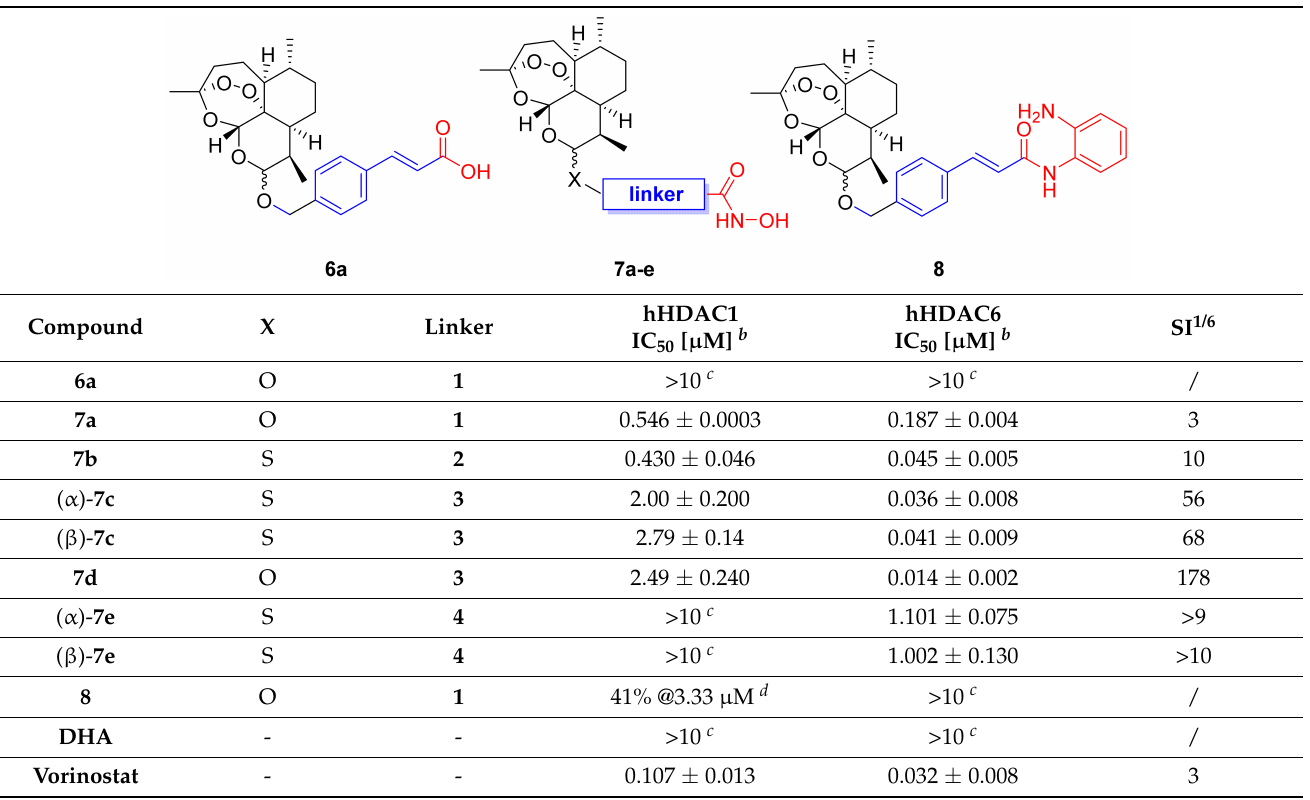
Table 1. Inhibitory activities of DHA–HDACi hybrids against human HDAC1 (hHDAC1) and HDAC6 (hHDAC6) a